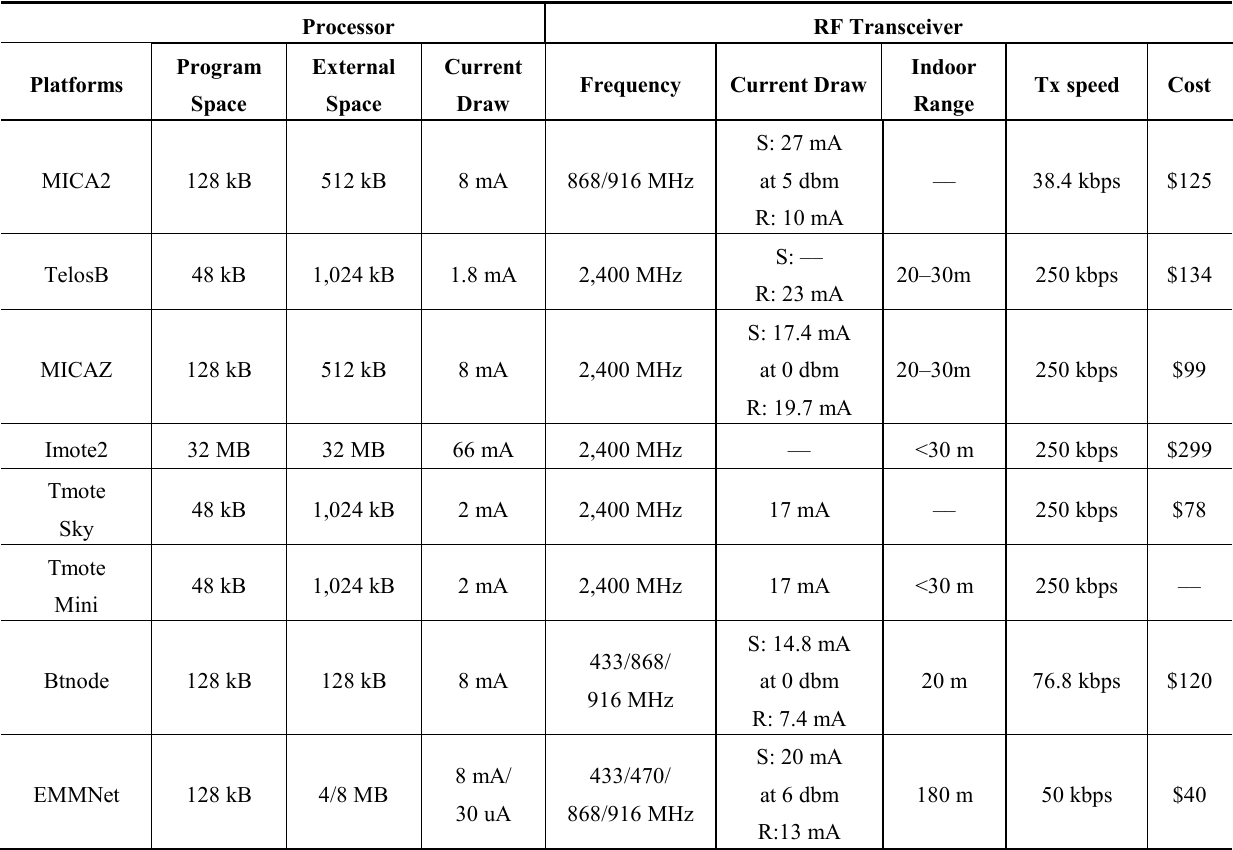
Table 1. Characteristic ubiquitous sensor network